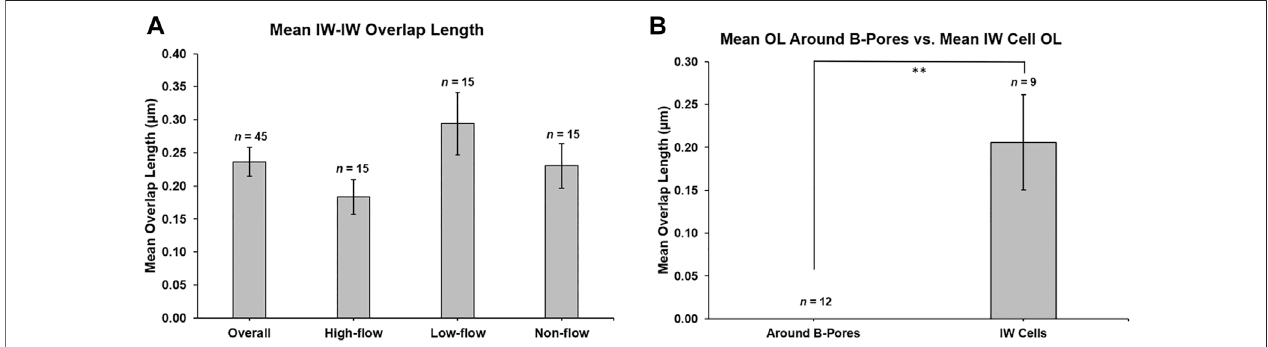
FIGURE 9 | Mean overlap length between adjacent inner wall cells. (A) : Mean overlap length (OL) was 0.236 ± 0.022 µm ( n = 45 cells), and this was not different between fl ow-type areas. (B): OL was measured on the sections before and after a B-pore was observed for 12 B-pores. OL was always 0 μ m, which was signi fi cantly less ( p ≤ 0.01) than the mean OL for the nine inner wall (IW) cells on which the B-pores were found. ** p ≤ 0.01. Error bars :